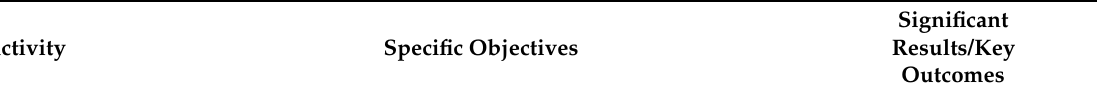
Table 1. Major activities, specific objectives, significant results and key outcomes for the first three steps regarding the development of the education-entertainment online